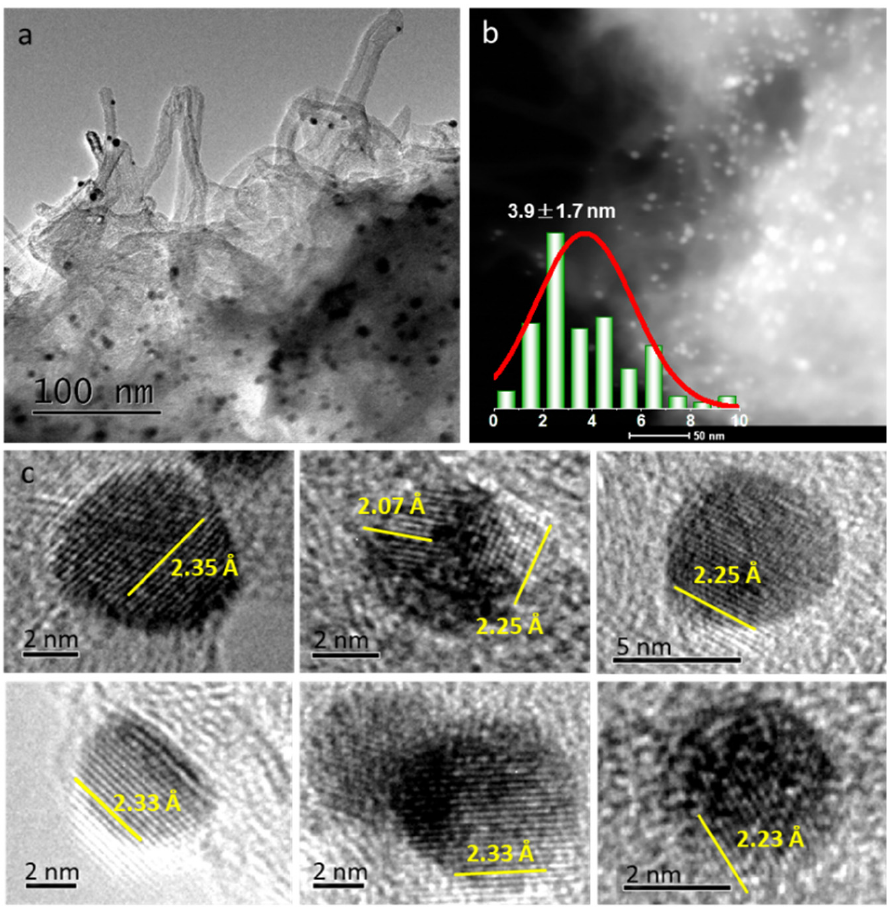
Figure 4. TEM image ( a ), HAADF-STEM images and size distribution ( b ), and high-resolution TEM images ( c ) of the typical AuNi 8 /CNT catalyst.